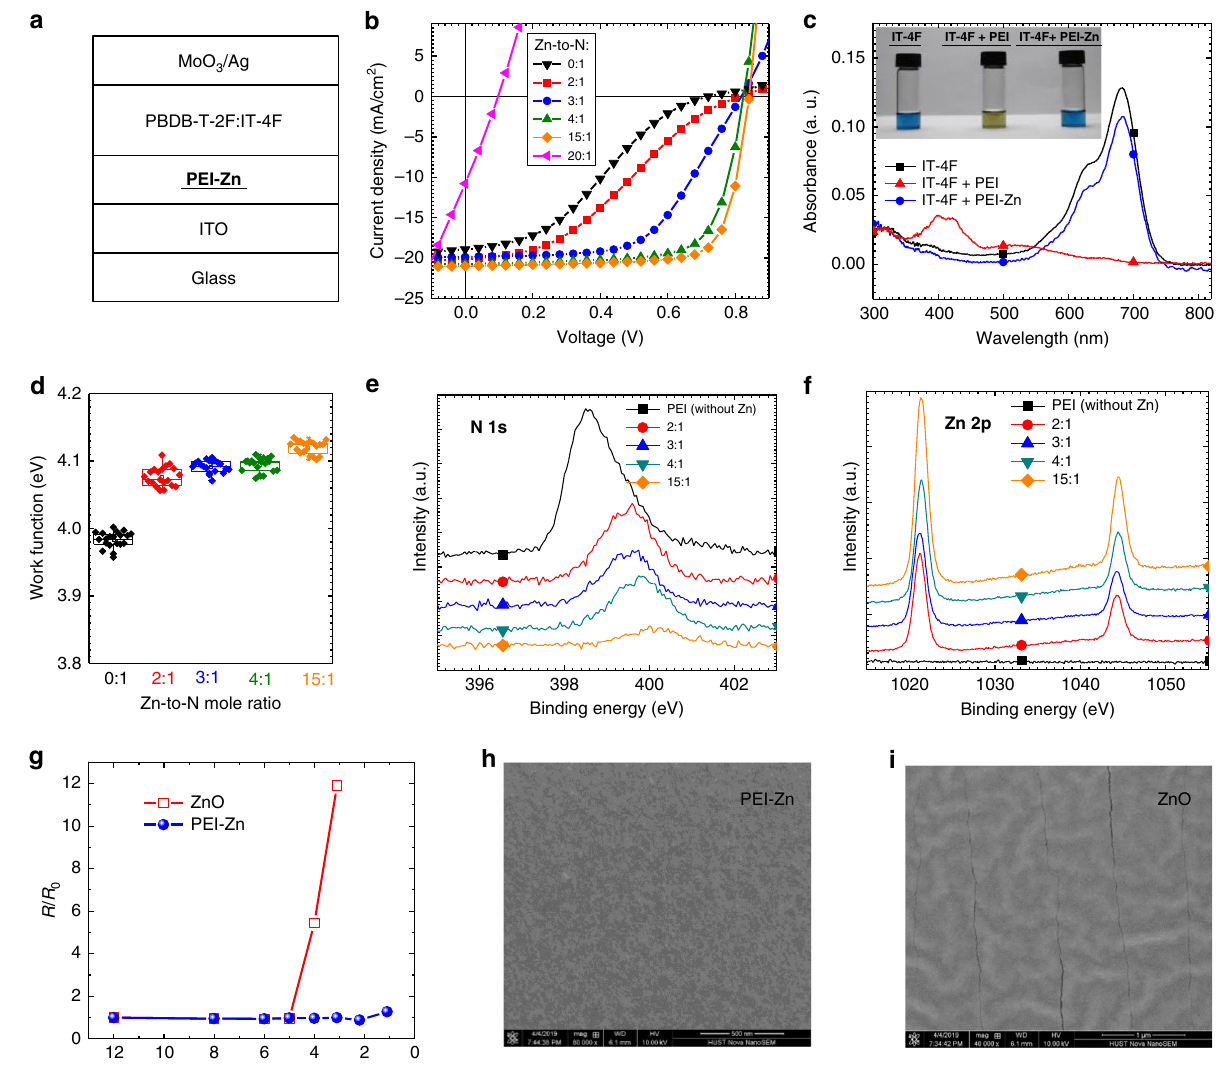
Fig. 2 Properties and evaluation of PEI-Zn as an electron-transporting layer in OSCs. a Structure of OSC devices used to evaluate the performance of PEI-Zn as an electron-transporting layer; b J - V characteristics of the devices with PEI-Zn ETL containing different Zn-to-N mole ratios; Zn-to-N mole ratio is shown in the legend. c Absorption spectra of three solutions: IT-4F, IT-4F mixed with PEI, and IT-4F mixed with PEI-Zn solution. The inset shows the pictures of the three solutions. 100 μ L 0.1 wt.% PEI and 100 μ L PEI-Zn (Zn-to-N 15:1) were added to 1 mL 0.02 mg mL − 1 IT-4F solution to study the reaction between them, respectively. d Work function of the PEI-Zn containing different Zn-to-N mole ratios; Boxes, square symbols, and horizontal bars indicate 25/75 percentile, mean, and min/max values, respectively. X-ray photoelectron spectroscopy of the PEI-Zn fi lms containing different Zn-to-N ratios: e N 1 s; f Zn 2p. g Strain test on the PEI-Zn and ZnO fi lms deposited on 175- µ m thick PES substrates. Resistance ratio of the fi lms after bending ( R ) over the initial value before bending ( R 0 ) as a function of the bending radius. SEM images the fi lms on PES substrates after 500 times continuous bending with a bending radius of 4 mm: h PEI-Zn fi lm; i ZnO fi